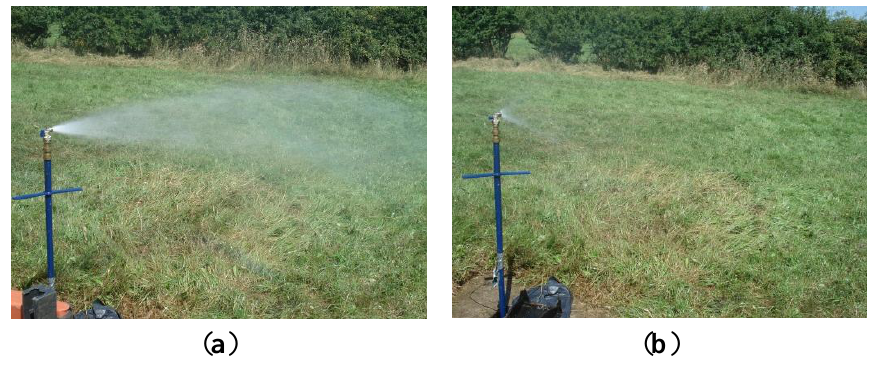
Figure 4. Leak induced in the pipe. ( a ) Strong leak; ( b ) Weak leak.